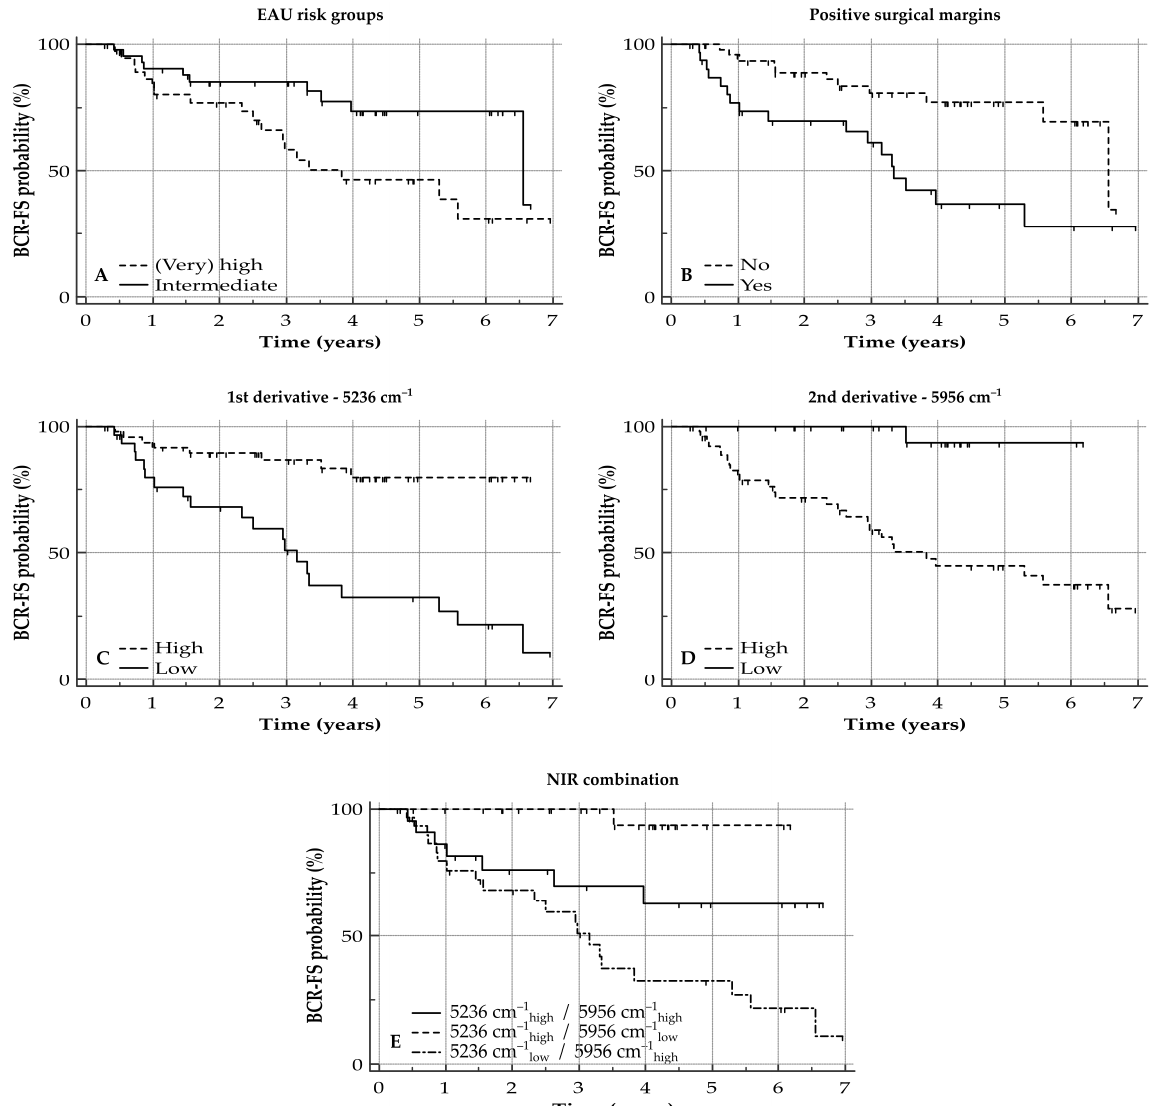
Figure 3. BCR-FS curves for clinical parameters and NIR spectral variations of interest. Y-axis depicts cumulative BCR-FS (%) and X-axis depicts survival time in years. BCR-FS curves are illustrated for ( A ) EAU risk groups (HR (very) high = 2.42 [1.14–5.13], p = 0.0209); ( B ) positive surgical margins (HR yes = 3.38 [1.54–7.43], p = 0.0024); ( C ) difference in intensity of 1st derivative at 5236 cm − 1 (HR high = 0.18 [0.08–0.39], p < 0.0001); ( D ) difference in intensity of 2nd derivative at 5956 cm − 1 (HR high = 4.53 [2.06–9.92], p = 0.0002); and ( E ) NIR combination marker (HR 5236 cm − 1 high/5956 cm − 1 high = 0.11 [0.05–0.28], HR 5236 cm − 1 low/5956 cm − 1 high = 2.52 [0.99–6.42], p < 0.0001). BCR-FS: biochemical recurrence-free survival; HR: hazard ratio; and NIR: near-infrared.